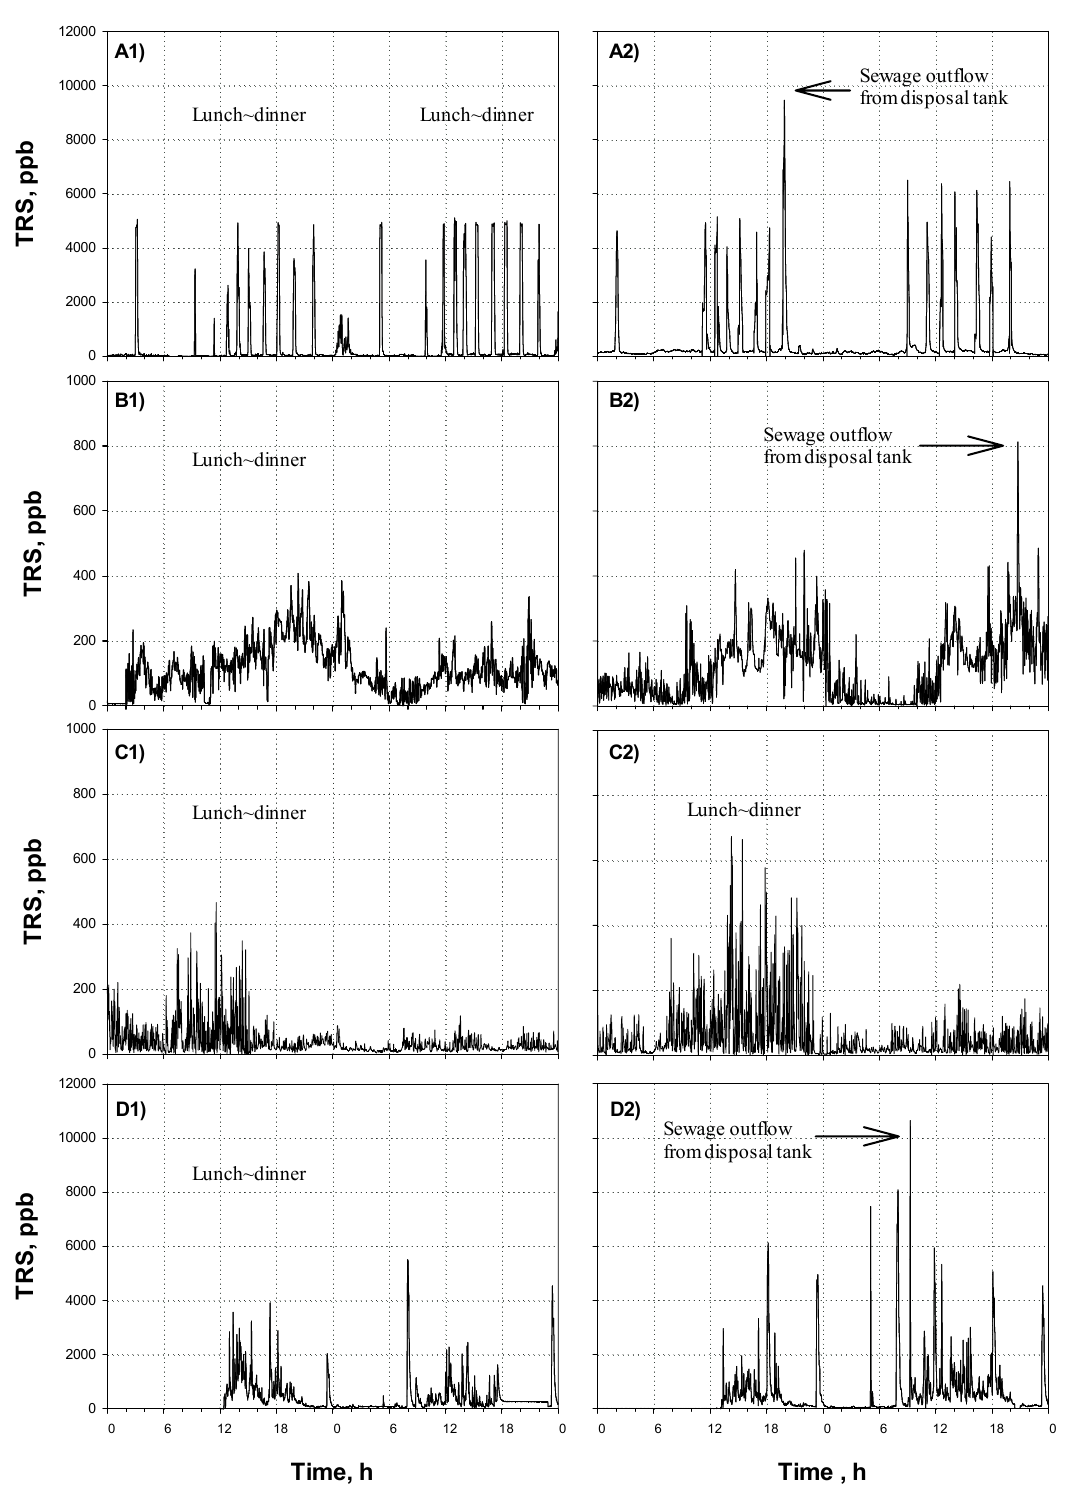
Figure 4. Time profiles of TRS measured at Districts-ONE − FOUR before and after application of